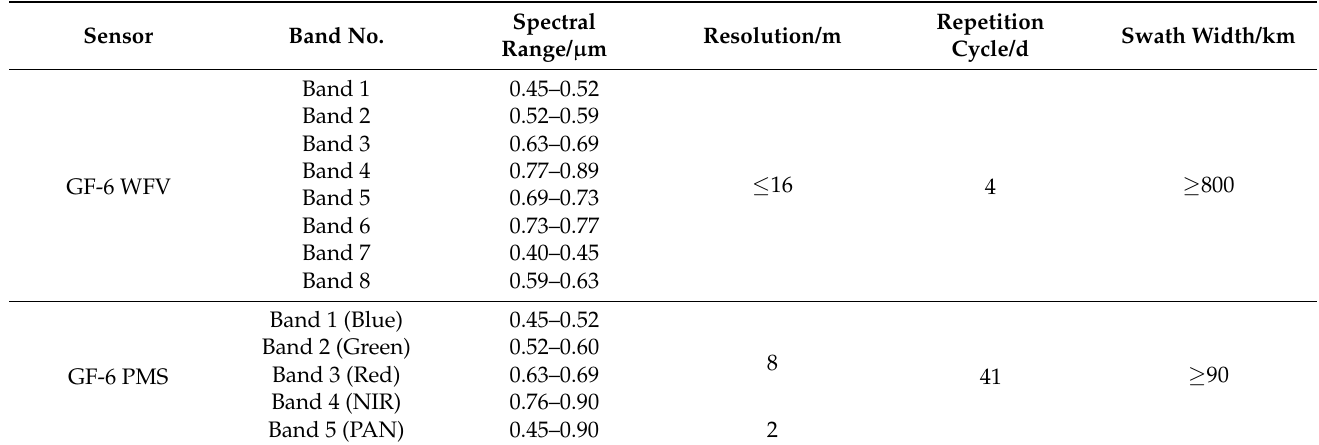
Table 2. Introduction of GF-6 WFV and PMS sensor parameters.